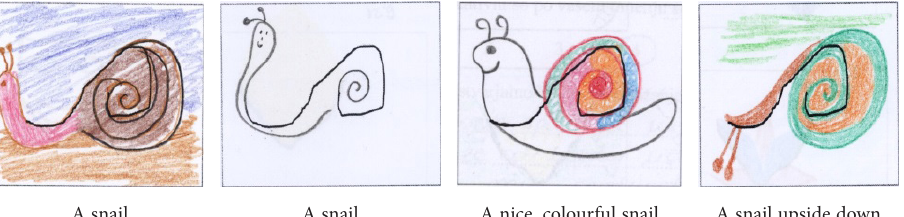
Figure 8. The creative task: interpretation of Fragment 2 – animals: snail (source: testingmom.com,